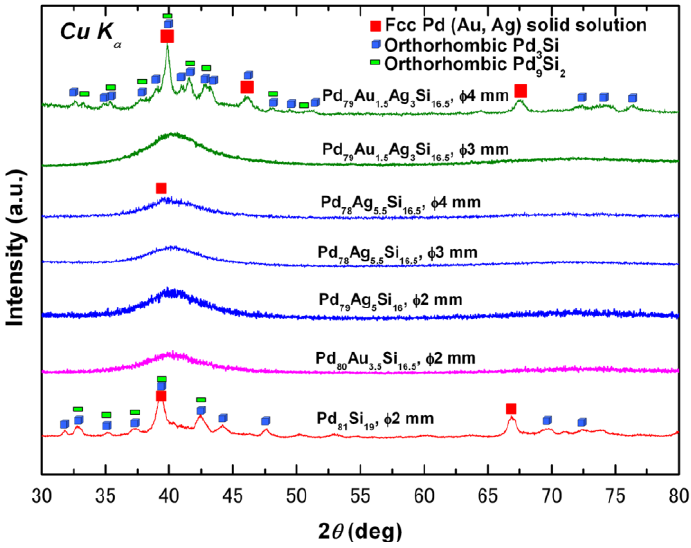
Figure 4. XRD patterns of the Pd-Si-based metallic